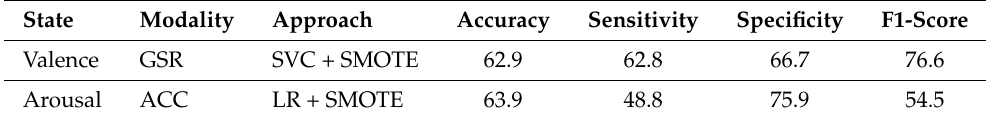
Table 4. Quantitative performance metrics for the moderately depressed